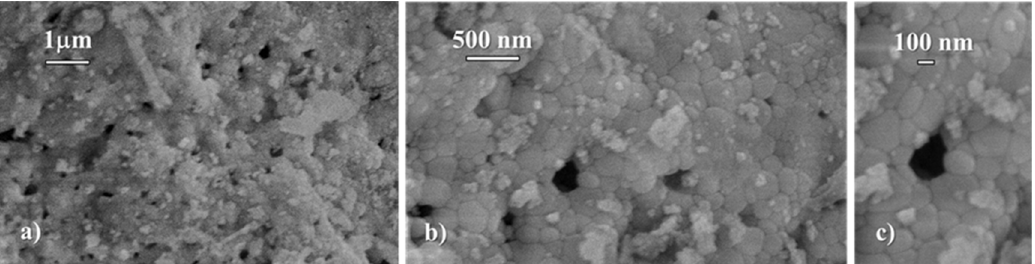
Figure 8. SEM images of Ce-CMK3 sample at different magnifications showing ( a ) cavities separated from each other by distances of about 1 µm, ( b ) well-connected particles forming the cavities, ( c ) a detailed view of a cavity.